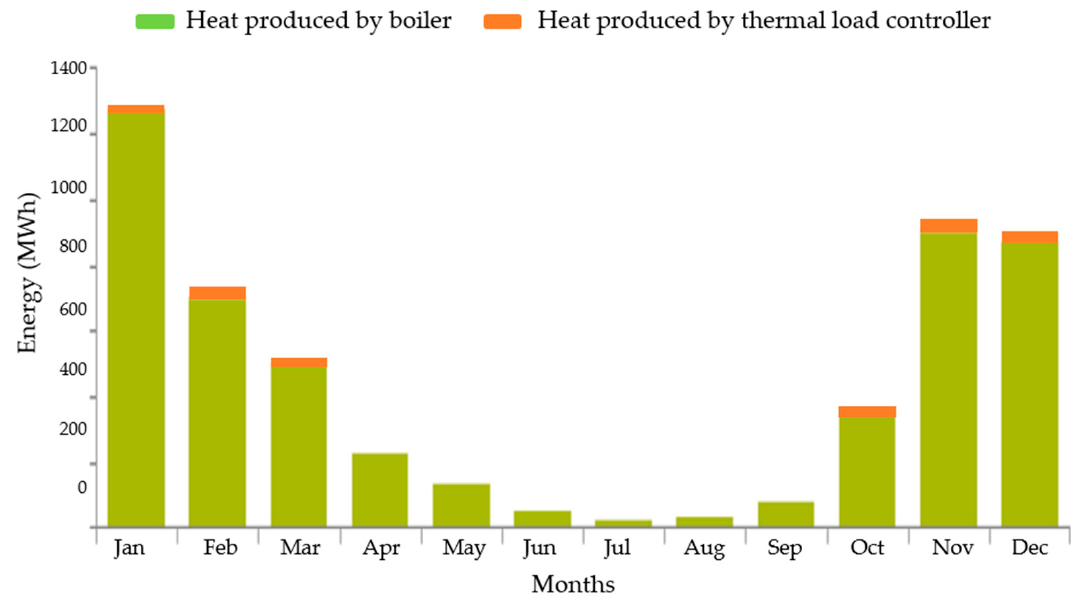
Table 6. Thermal energy demand and production.